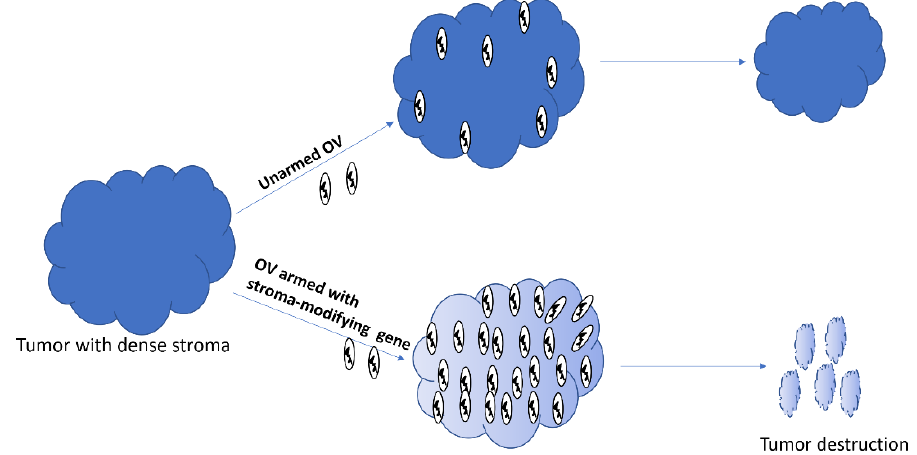
Figure 3. Oncolytic viruses armed with stroma-modifying genes can spread better within the tumor, and subsequently destroy it.